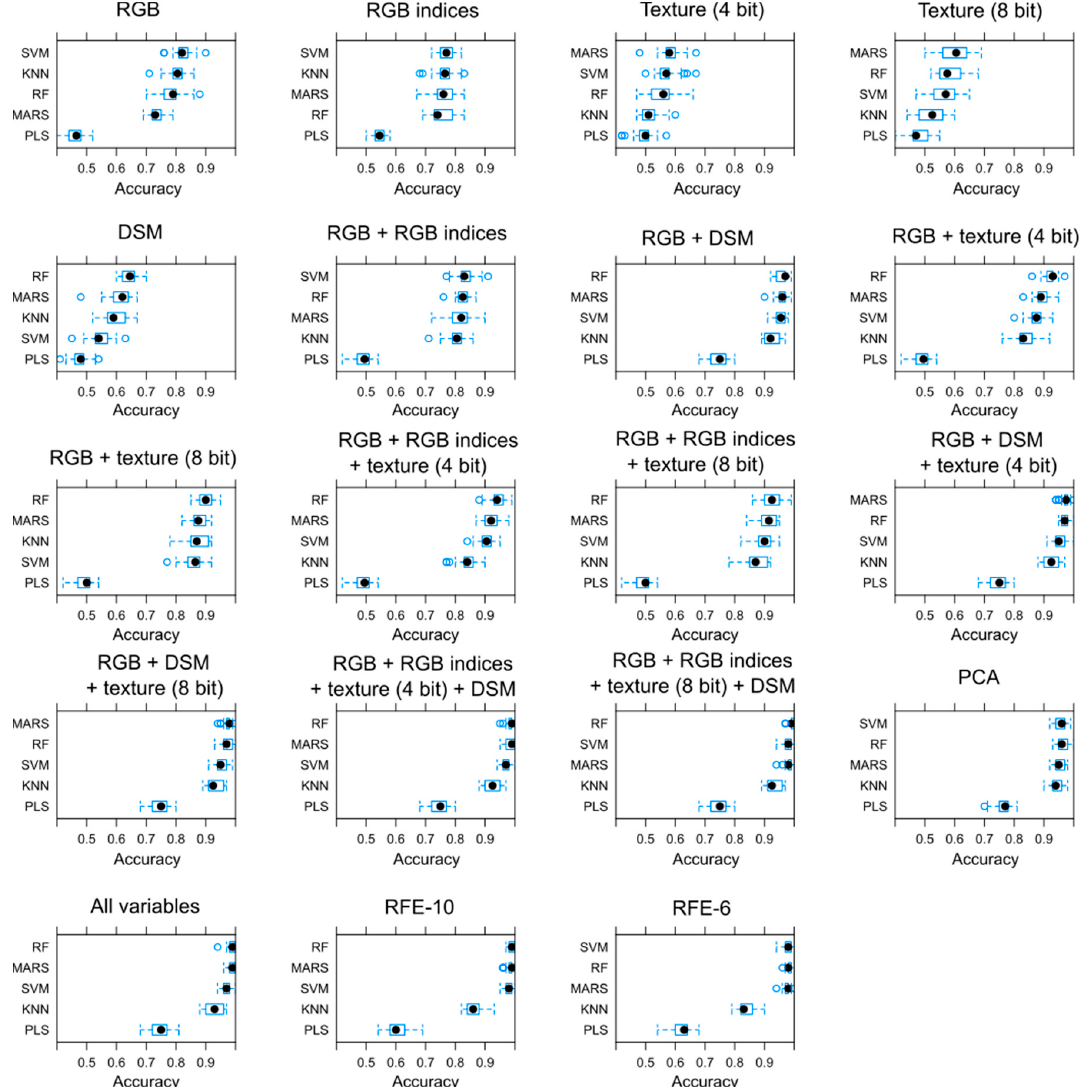
Figure 5. Classification accuracies using different variable sets and classifiers. Boxplots represent the medians (•), interquartile ranges, minimums, maximums (whiskers), and outliers (o) based on 30 models of repeated k-fold cross-validation (RKCV).